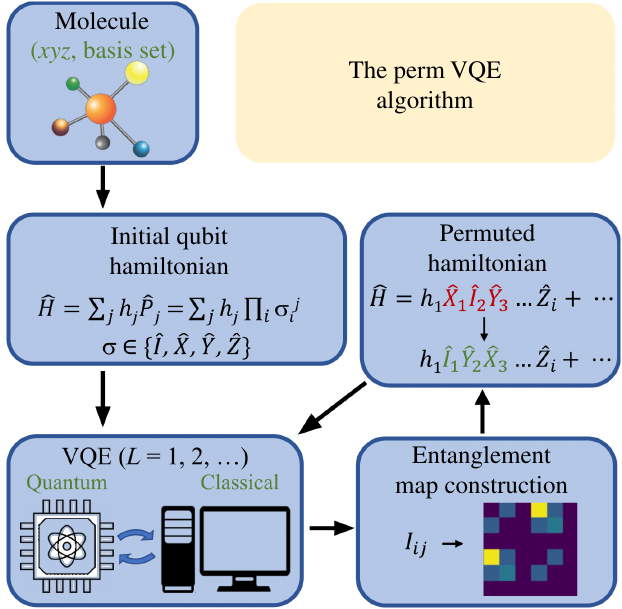
FIG. 2. The PermVQE algorithm. After the approximate ground-state wave function is obtained from the initial Hamilto- nian at a fixed circuit depth L through the VQE, the entanglement map is produced on the basis of mutual information I ij . Min- imization of a cost function (which quantifies the amount of long-range correlations) over possible permutations of qubits returns the permuted Hamiltonian, which is then fed back into the VQE algorithm. This procedure is iteratively repeated until the best-permuted Hamiltonian is generated, from which the best- possible (within L ) ground-state wave function and energy are